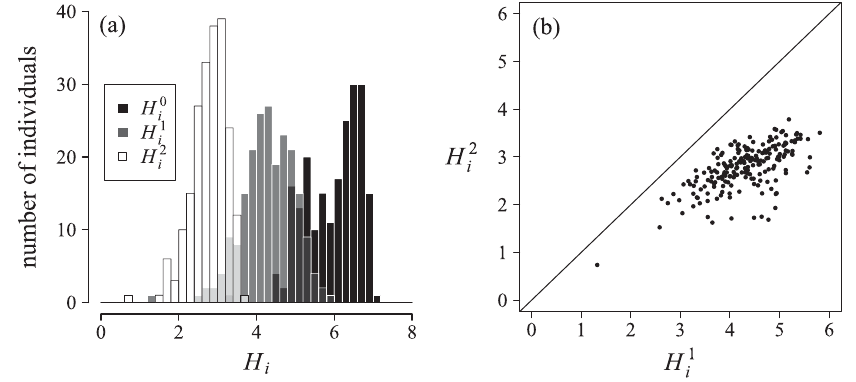
FIG. 8. (a) Histograms of the entropies for D